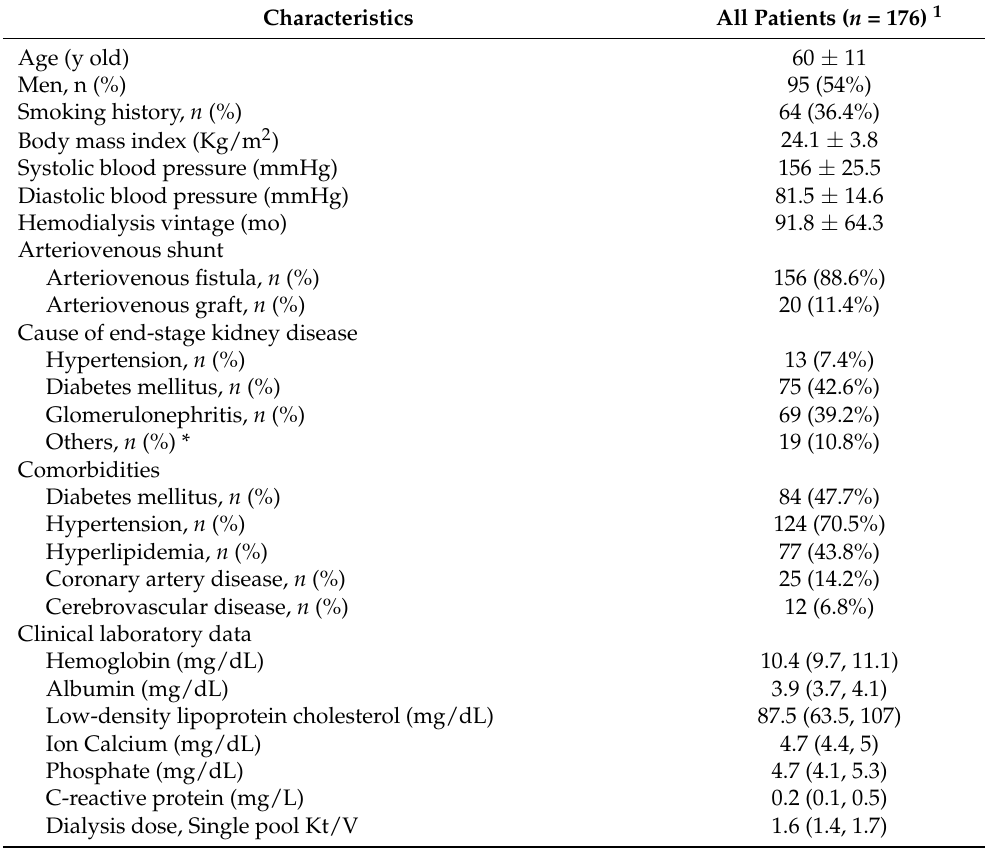
Table 1. The baseline characteristics in hemodialysis participants.